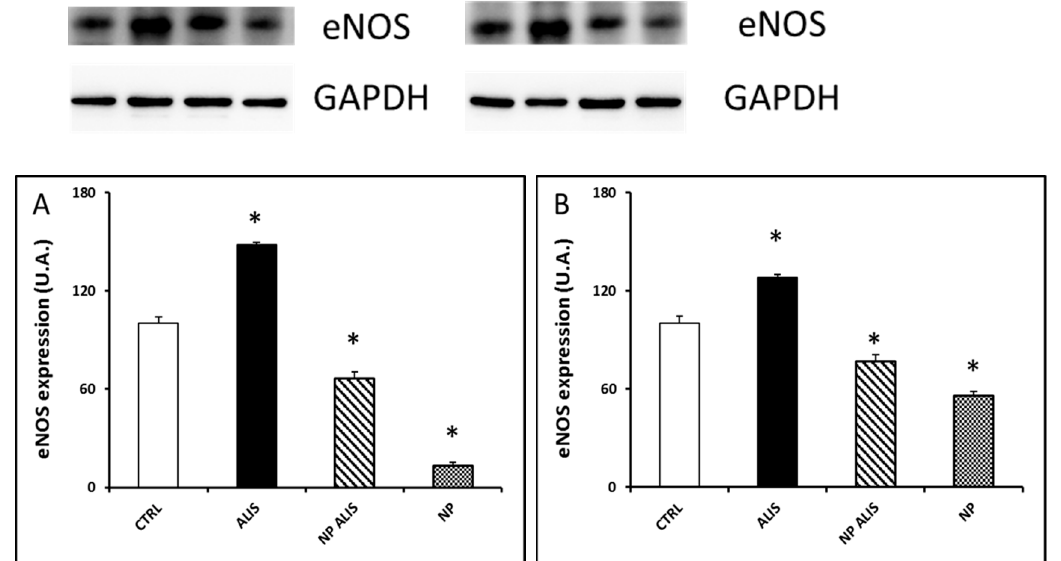
Figure 7. Effect of powdered aliskiren (ALIS), nanoparticle-loaded aliskiren (NP ALIS), and nanoparticles only (NP) on endothelial nitric oxide synthase (eNOS) protein expression in the left ventricle ( a ) and aorta ( b ). * p < 0.01 vs. CTRL; Values represent mean ± SEM of 6 animals.